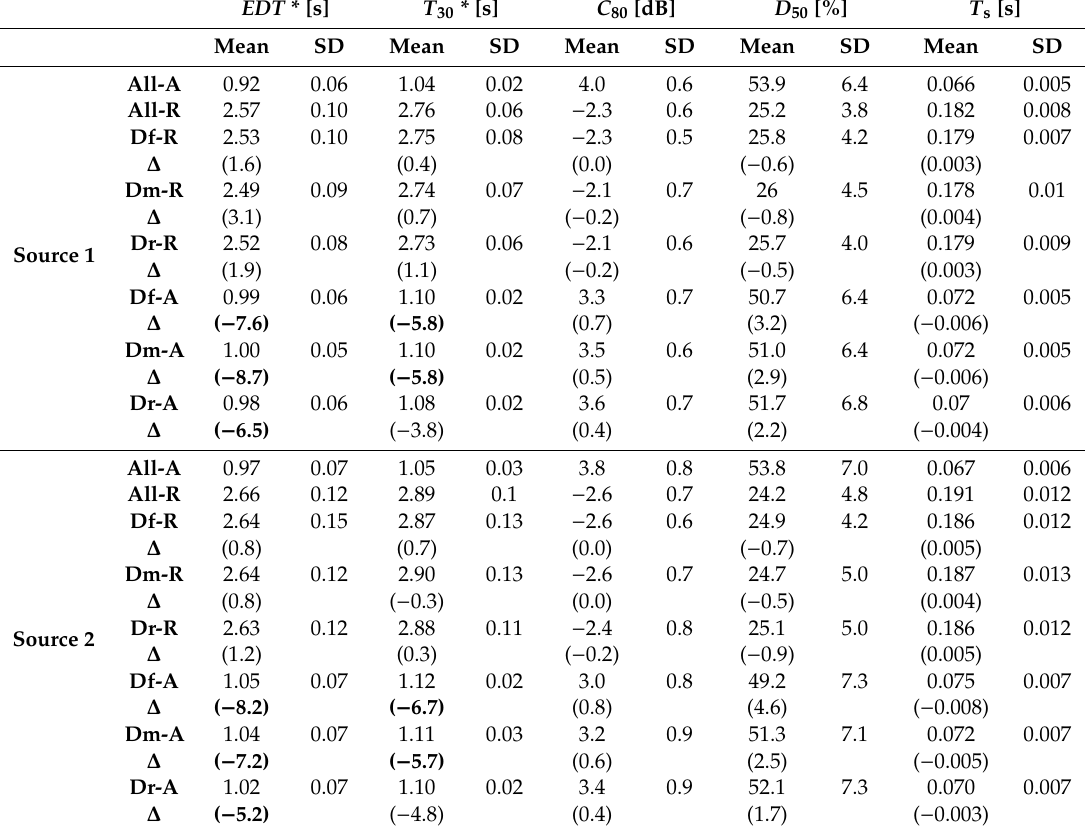
Table 3. Spatial mean values and overall standard deviation of reverberation time ( T 30 ), early decay time ( EDT ), clarity ( C 80 ), definition ( D 50 ), center time ( T s ) in the eight conditions. Di ff erences ( ∆ = All − D) with respect to the reference configurations All-A and All-R are given in brackets for each configuration (Df, Dm, and Dr). The di ff erences above the JND have been highlighted in